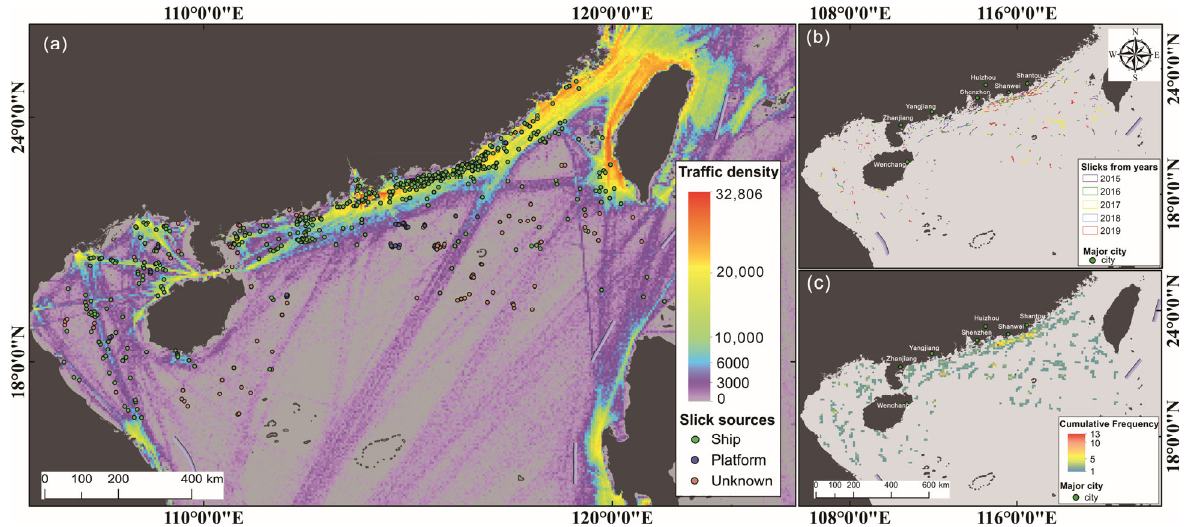
Figure 10. ( a ) Traffic density and the determined slick origins in the study area; ( b ) distribution of oil spills in the NSCS; ( c ) oil slick cumulative distribution (grid: 10 × 10 km 2 ). The extracted oil slicks were further binned into 10 × 10 km 2 grids (Figure 10c), where the value of the grid denoted the number of times the detected slicks covered this region during 2015–2019. Oil slicks were most frequently observed south of Huizhou city, where a total of 13 oil spills were detected. The coastal area from Shenzhen to Shantou repre ‐ sented a high incidence of oil spill regions in the NSCS (Figure 10c). Eight oil slicks were detected in the offshore area east of Hainan Island. However, the above hot spot was